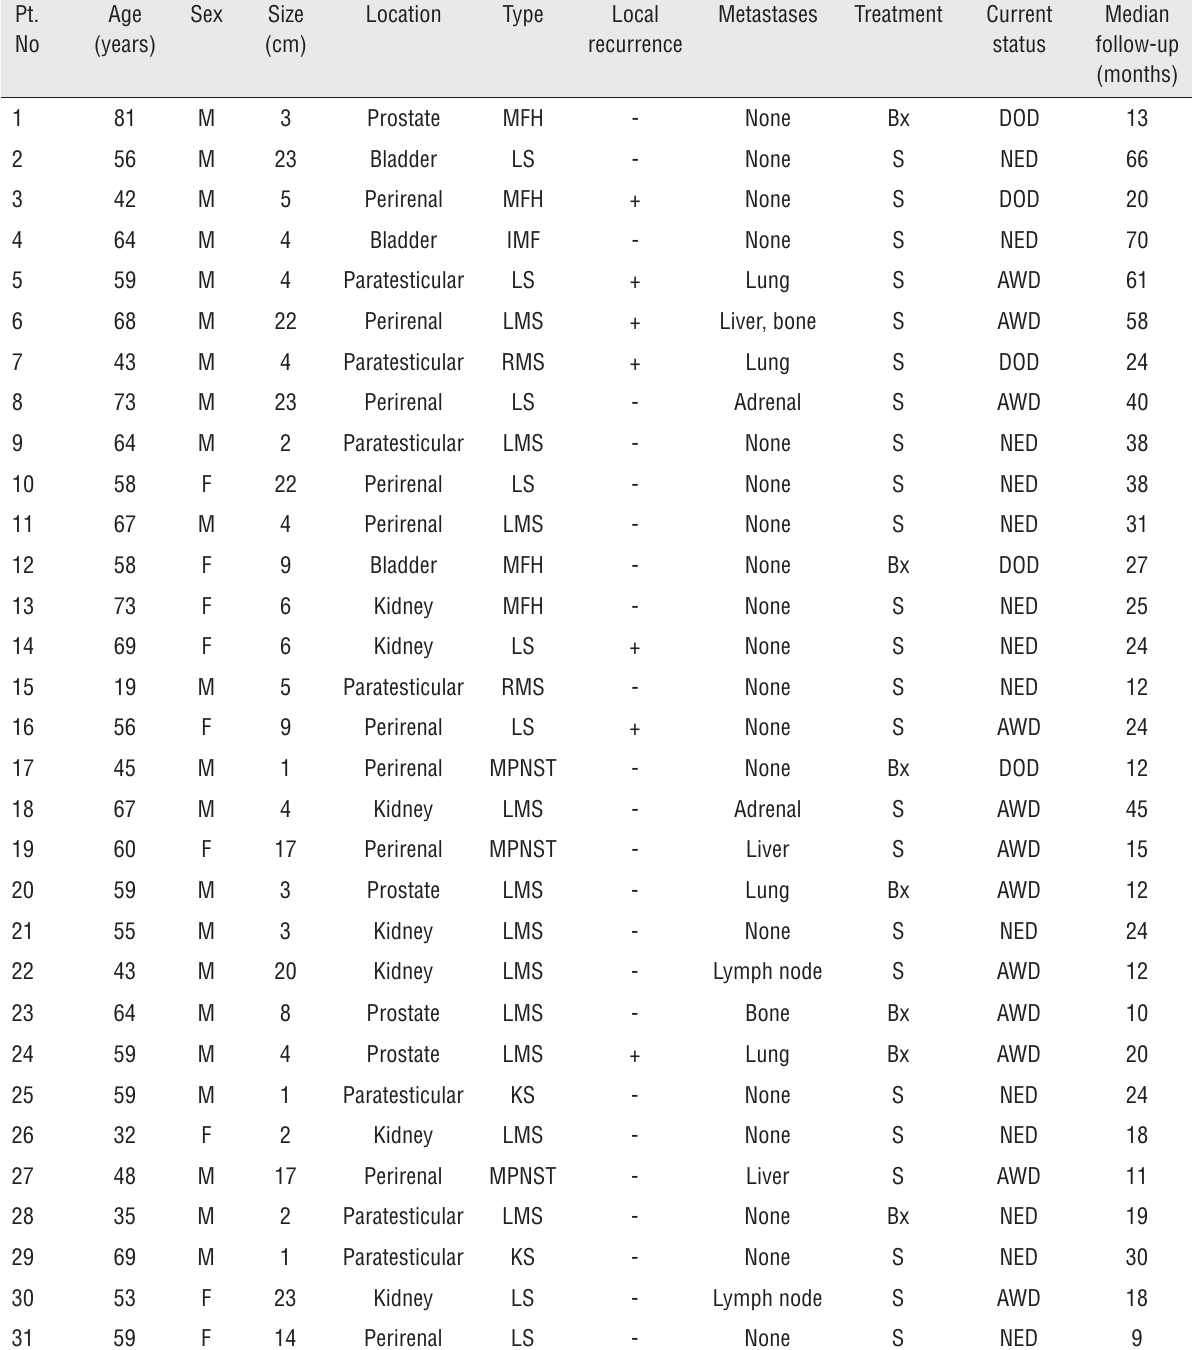
Table 1 - Distribution of 31 genitourinary sarcomas according to selected clinical and pathological characteristics.